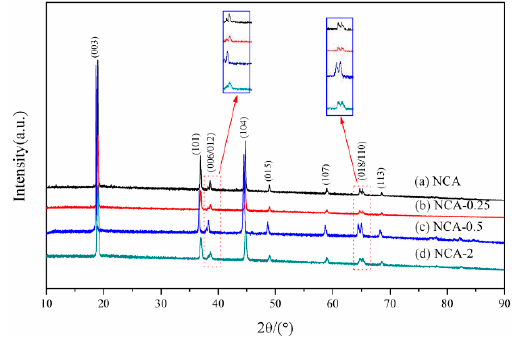
Figure 1. XRD patterns of four samples, NCA, NCA-0.25, NCA-0.5 and NCA-2.